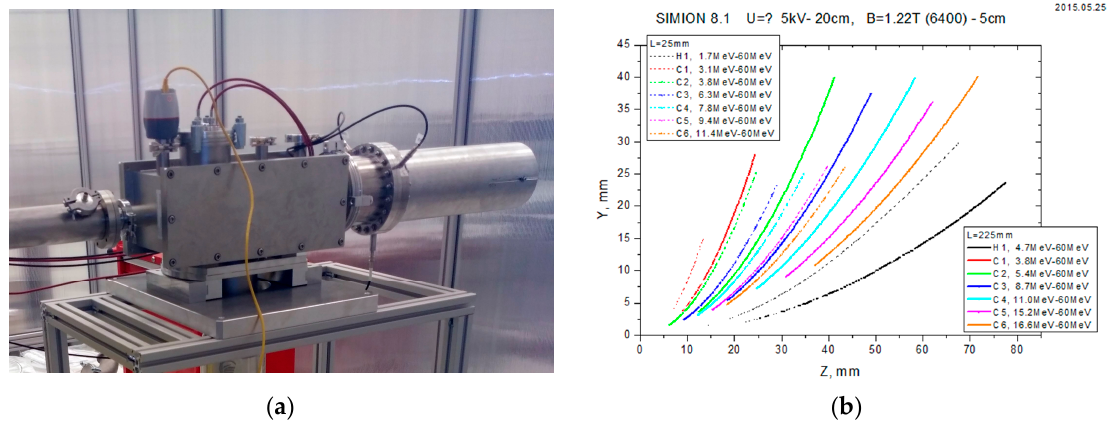
Figure 2. ( a ) Picture of the ELIMAIA Thomson parabola spectrometers (TPS); ( b ) SIMION simulation of the TPS performances.